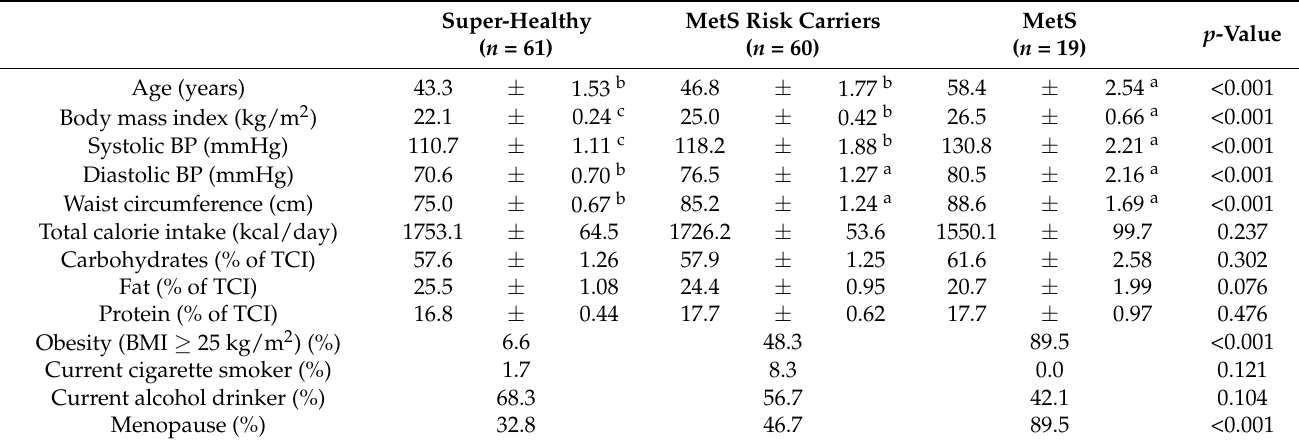
Table 1. Baseline characteristics and biochemical parameters of the study participants according to the metabolic syndrome (MetS)